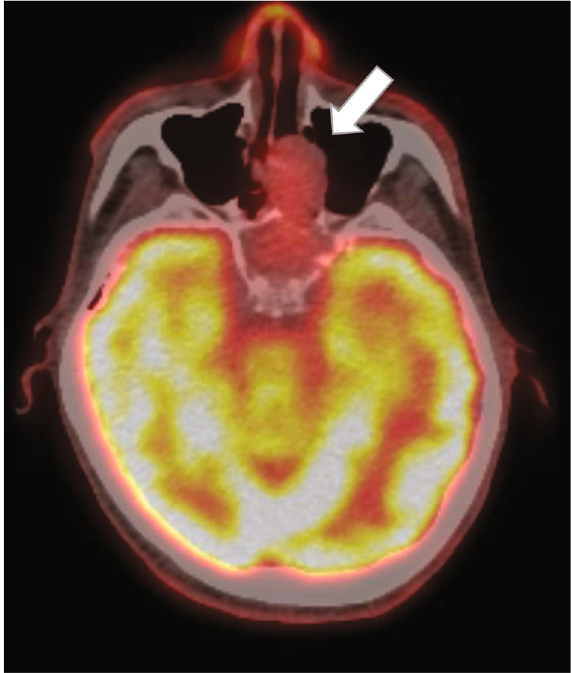
Figure 2: A neoplastic lesion (white arrow) is shown in the maxillary sinus on a positron emission tomography scan in 2013.